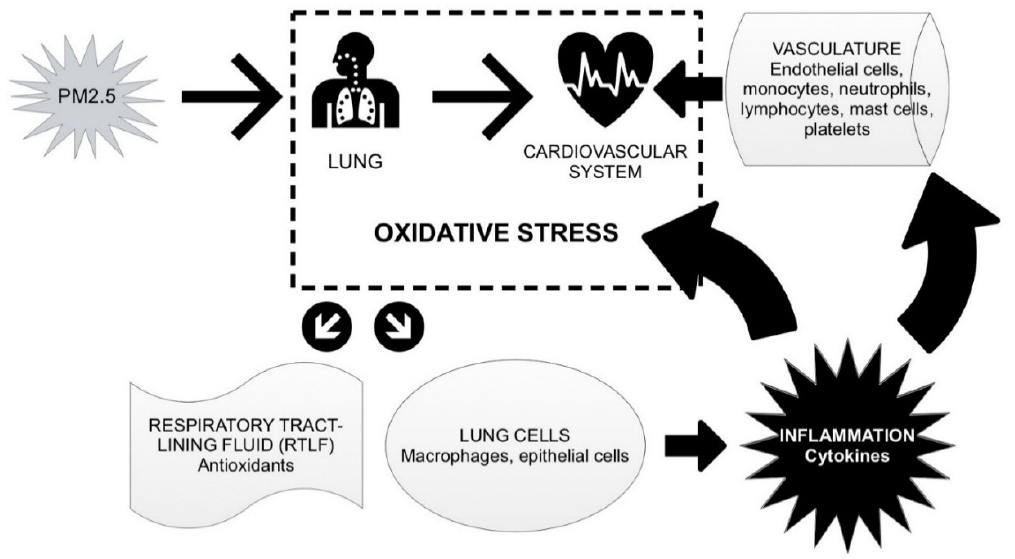
Figure 2. Possible biological pathways linking fine particulate matter (PM 2.5 ) exposure with inflammatory and oxidative